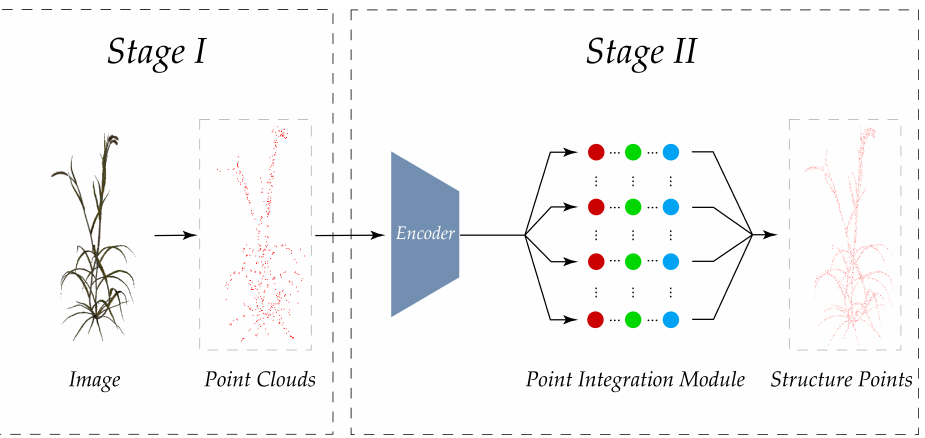
Figure 3. Stage I reconstructs a sparse point cloud from a single image, and the point cloud is used as the input to generate final structure points in stage